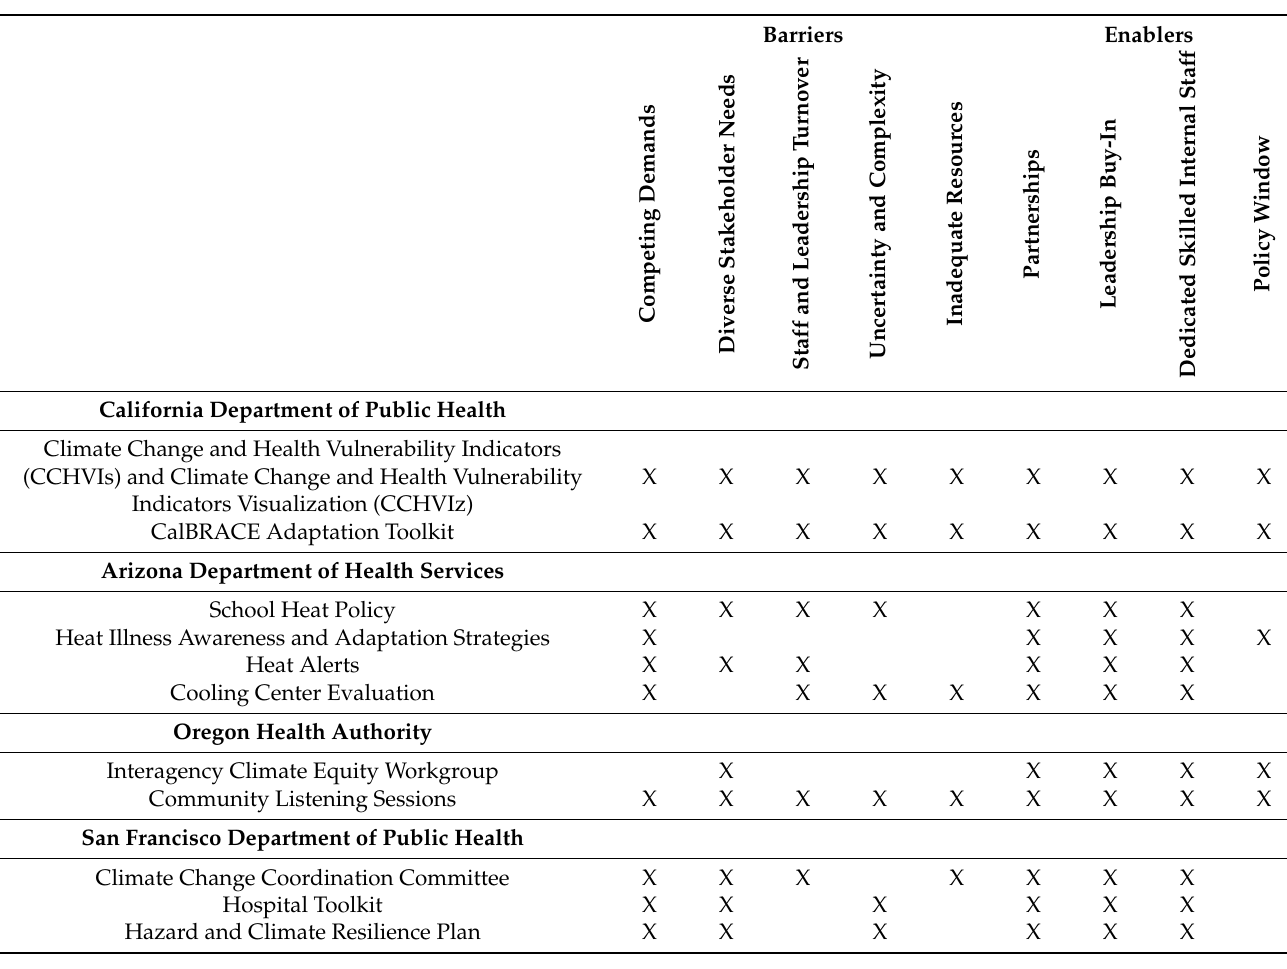
Table 2. Barriers and enablers encountered in each